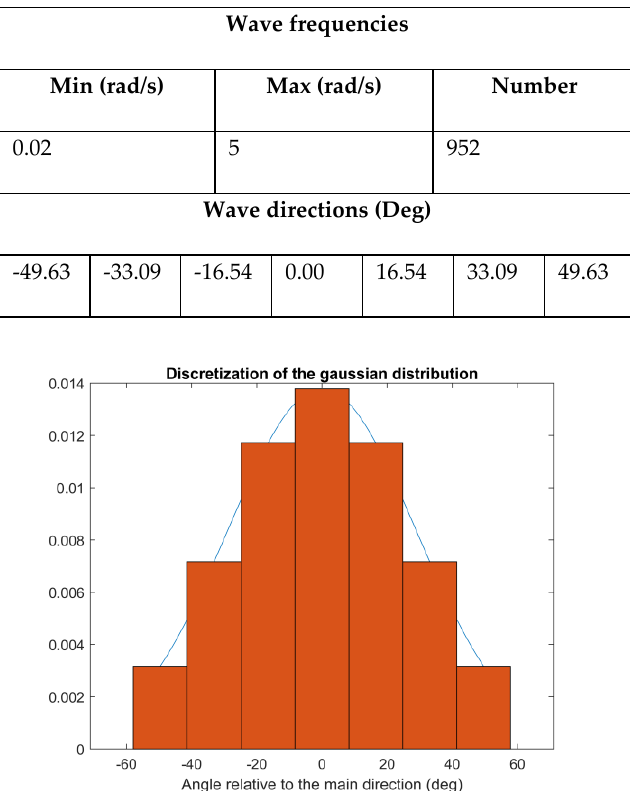
Fig. 5: The discretization of the directional distribution for the uniform distribution.